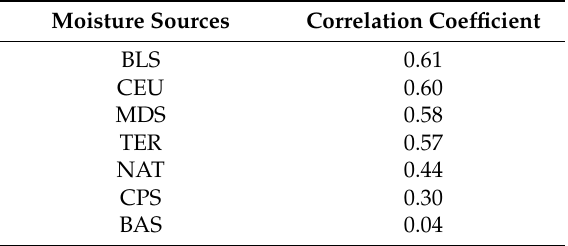
Table 4. Pearson correlation coefficients between the time series of monthly anomalies in the moisture supply from the sources to the Central European region and the SPEI-1 for the period 1980–2015 (432 times). Except for the BAS, the coefficients are significant at 99.9%, according to Student’s t -test. Moisture